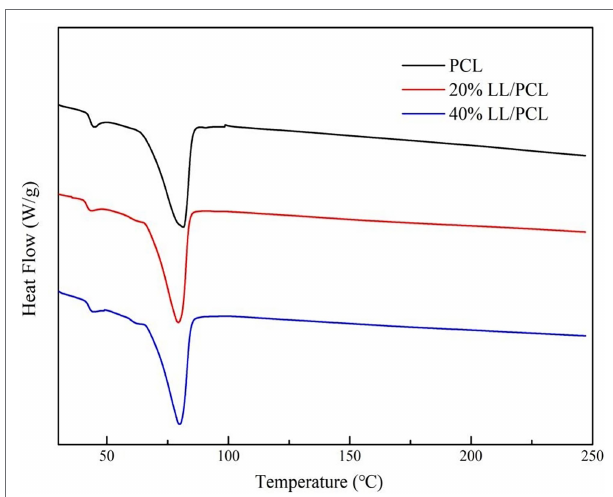
FIGURE 3 | DSC diagrams of LL/PCL fibrous membranes.